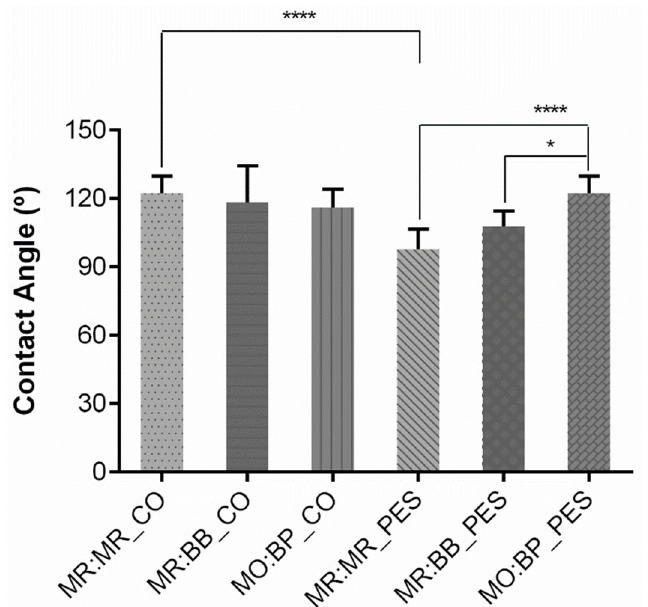
Figure 6. Contact angle measurement of cotton (CO) and polyester (PES) after coating with different pH-sensitive formulations: methyl red and bromothymol blue (MR:BB); methyl red and methyl red sodium salt (MR:MR); and methyl orange and bromocresol purple (MO:BP), (n = 10, ±SD), * p < 0.05, **** p < 0.0001 (one-way ANOVA, Šídák’s test).